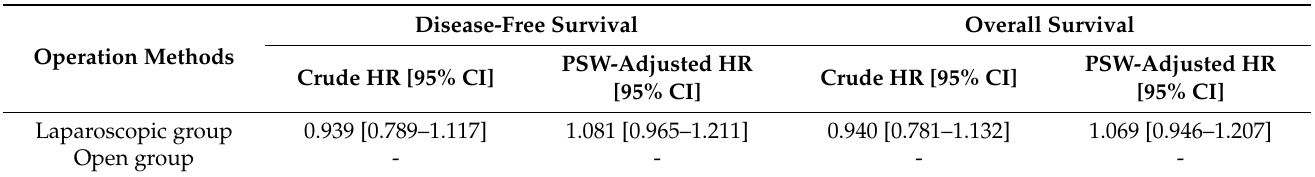
Figure 3. Cause-specific mortality after propensity score weighting. ( A ). Death from this cancer; ( B ). Death from other causes. Table 3. Results of the estimated hazard ratio of patients treated with open surgery vs.